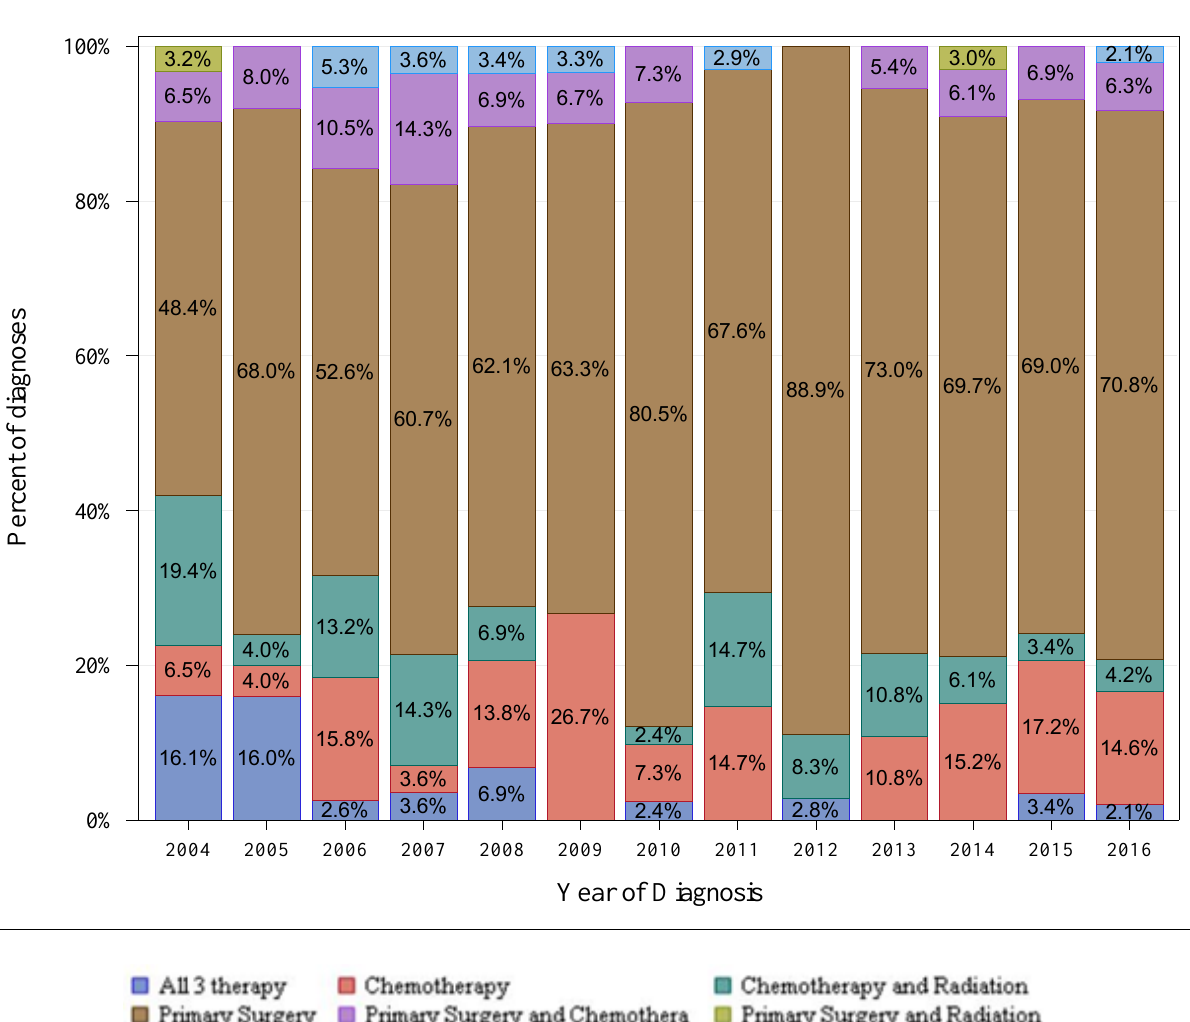
Figure 3. Differences in SEER-18 Localized Stage by Type of Therapy (Excluding pNET), 2004–2016, Ages < 50.